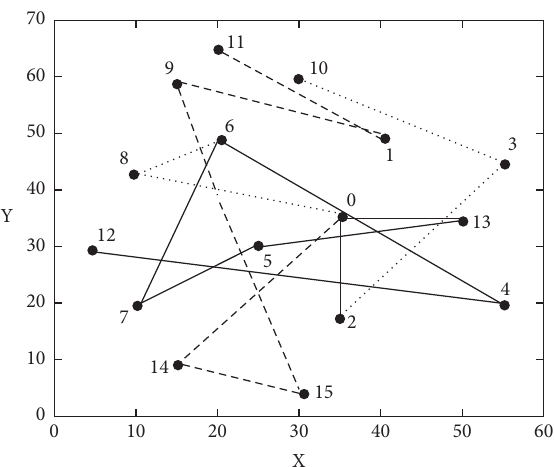
Figure 11: Generation diagram of distribution